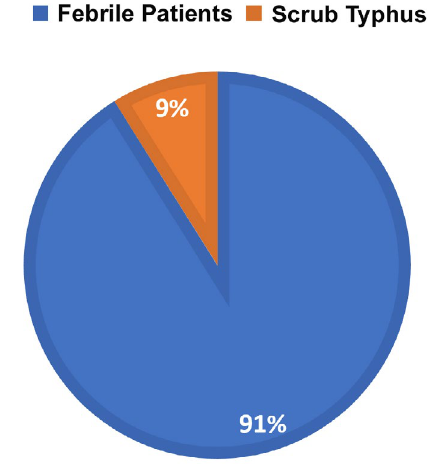
Fig. 1. Distribution of scrub typhus among serum samples of febrile